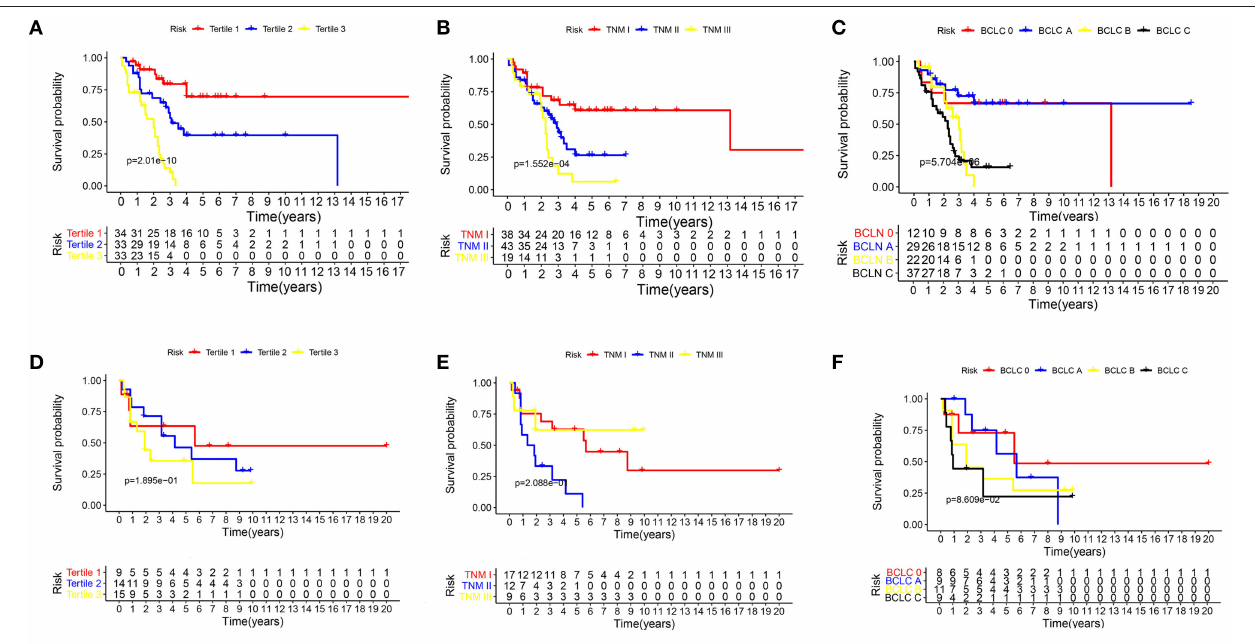
FIGURE 4 | The Kaplan–Meier curves for subgroups of patients. Patients were stratified by the prognostic score (A) , TNM stage (B) , and BCLC stage (C) in the training cohort. Patients were stratified by the prognostic score (D) , TNM stage (E) , and BCLC stage (F) in the external validation